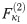
Time variation of the components of added-mass lift FκI(2) for the (a) hawkmoth and (b) fruit fly over one flapping cycle. Surface contours of added-mass lift FκI(2) at instants corresponding to peak values in the flapping cycle for the (c) hawkmoth and (d) fruit fly. Chord-lines at a few instances with black and green vectors corresponding to dU⃗/dt and −n^(ΔΦ(2)) respectively where ΔΦ(2) is the difference in scalar Φ(2) on the two sides of the wing, are also shown. Note the supination and downward movement of the wing in early upstroke. During this time, the vectors corresponding to dU⃗/dt and −n^(ΔΦ(2)) are pointing in similar directions so that their dot-product generates a positive (upward) lift force, creating a net positive centripetal acceleration reaction contribution during upstroke. Scaling of various components of lift with Reynolds numbers for the (e) hovering hawkmoth and (f) fruit fly. The black, green, red and cyan lines represent total, vortex-induced, added-mass and viscous components of lift, respectively.